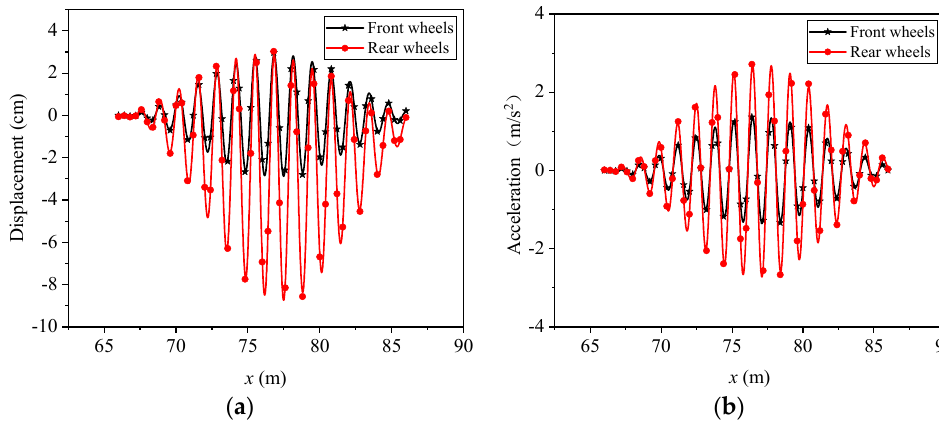
Figure 7. Net displacement ( a ) and vertical acceleration ( b ) of front and rear wheels 2 ns ≤ x ≤ 2 ns + ( b + c ) ( n ∈ N* ).